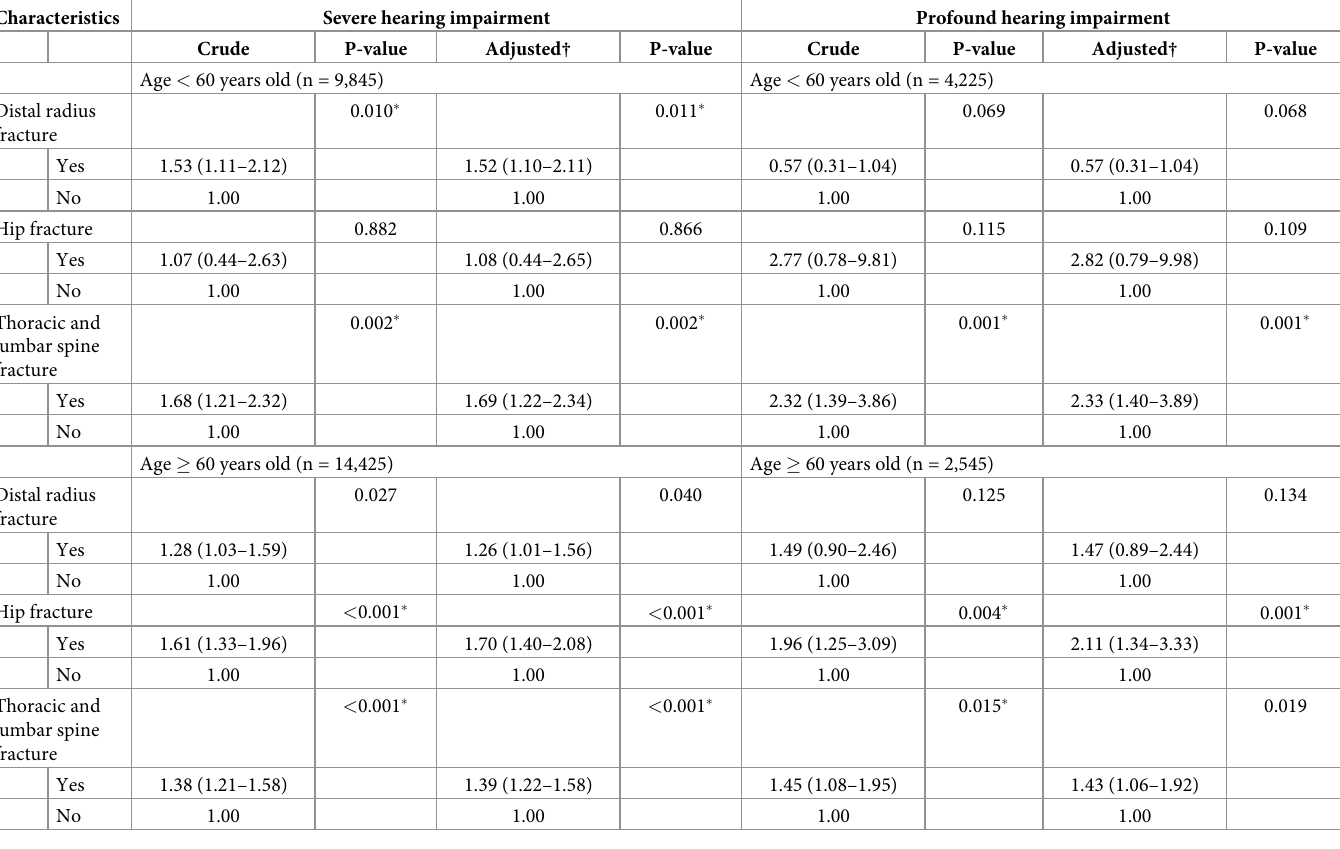
Table 3. Crude and adjusted hazard ratios (95% confidence interval) of hearing impairment for distal radius/hip/thoracic and lumbar fracture in subgroup analysis according to age.